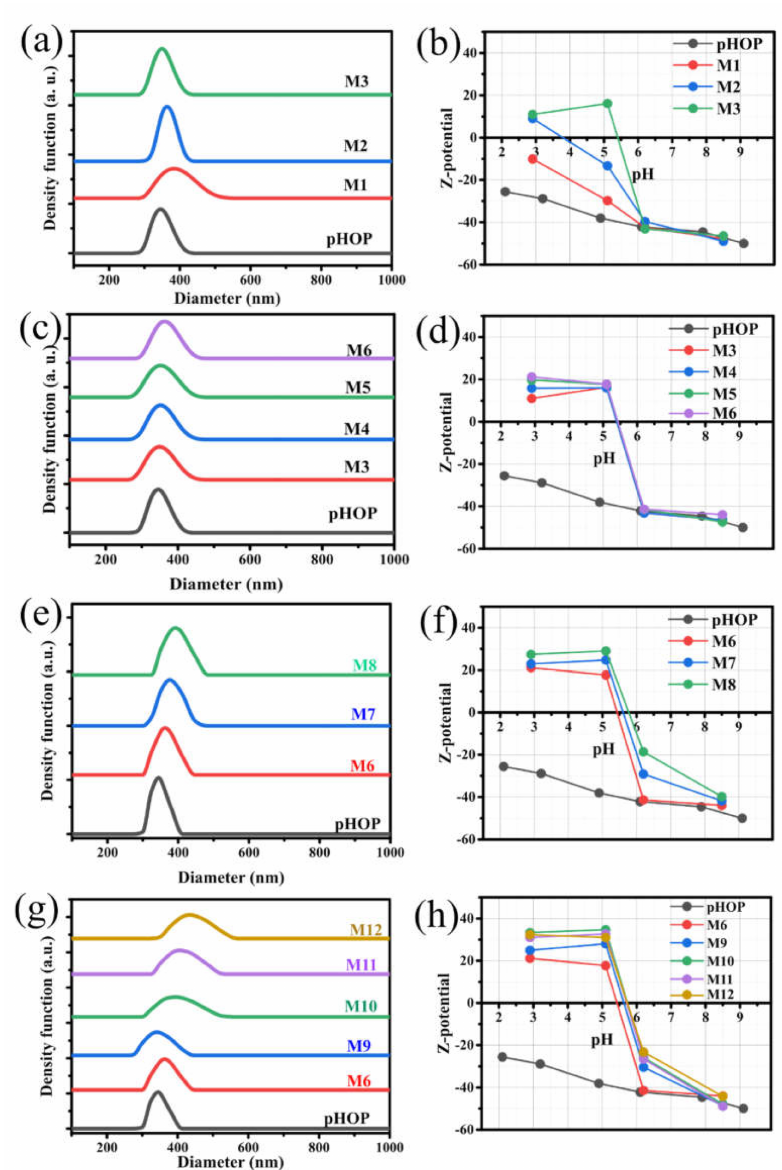
Figure 3. Intensity weighted size distributions from DLS measurements and Zeta potential values of pHOP and pHOP-NH 2 samples prepared at ( a , b ) different pH environments, acidic (M1), medium (M2), and basic (M3), ( c , d ) different reaction temperatures, 30 (M3), 40 (M4), 50 (M5), and 60 ◦ C (M6), ( e , f ) different reaction times 10 (M6), 30 (M7), and 60 min (M8) and ( g, h ) different APDEMS concentrations, 0.6 (M6), 1.2 (M9), 1.8 (M10), 2.4 (M11) and 3.0 µ mol